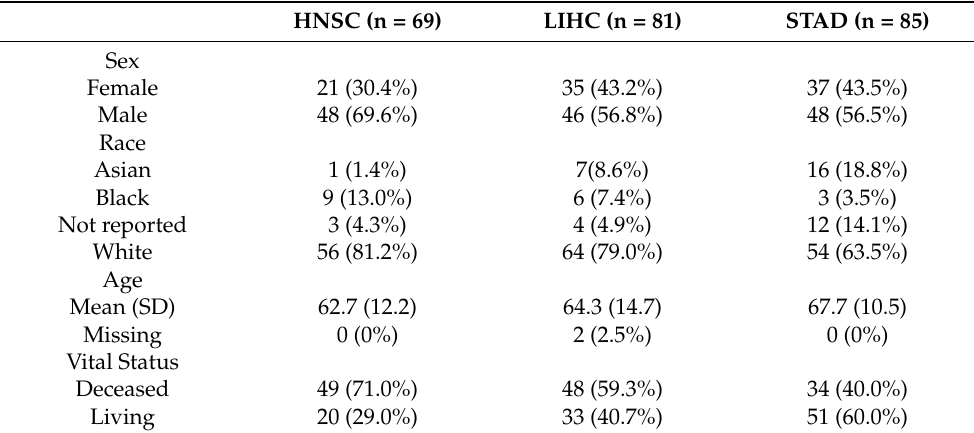
Table 1. Population characteristics for HNSC, LIHC, and STAD